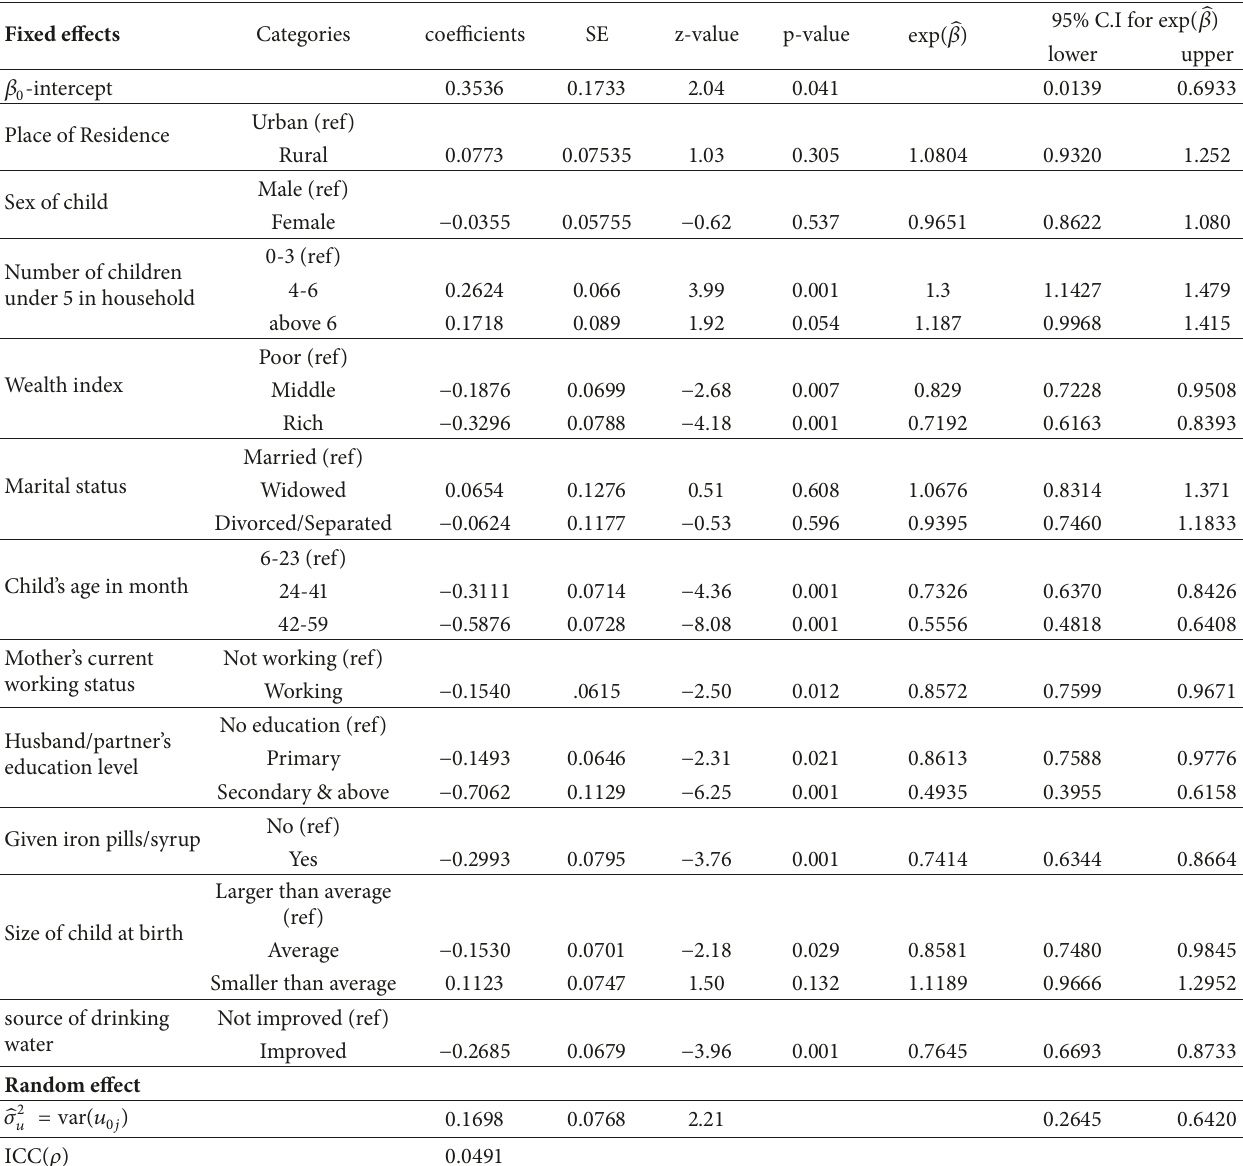
Table 3: Estimates of random intercept model (EDHS,